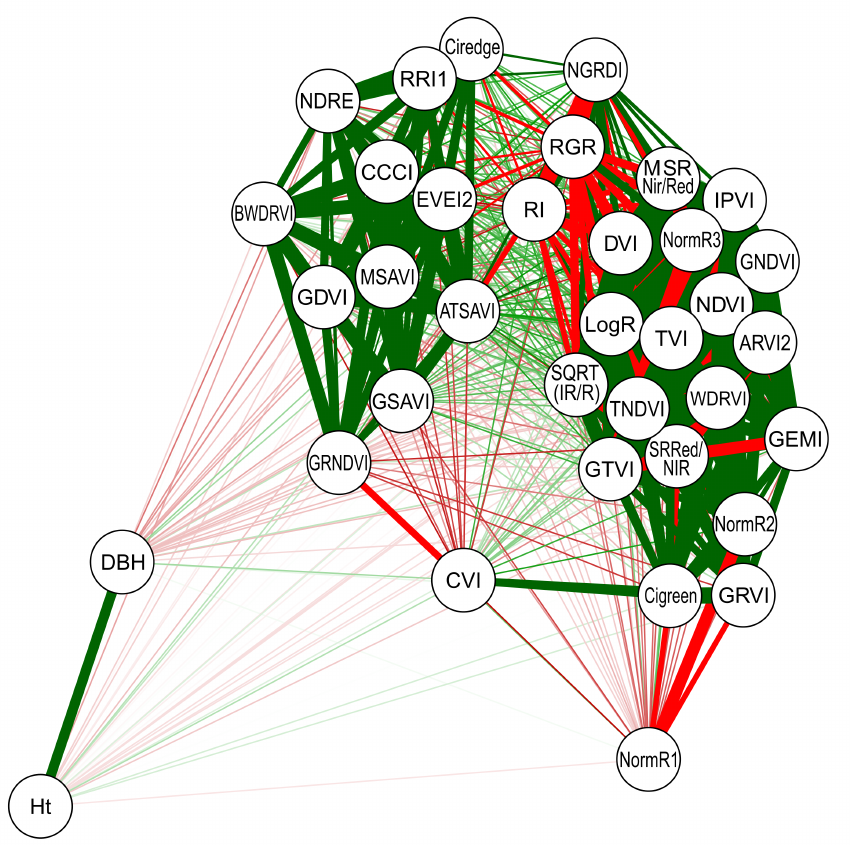
Figure 2. Pearson’s correlation network between variables diameter at breast height (DBH), total height (Ht), and vegetation indices evaluated in six eucalyptus species. Red lines link negatively correlated variables, while green lines link positively correlated variables. The line thickness is proportional to the magnitude of the